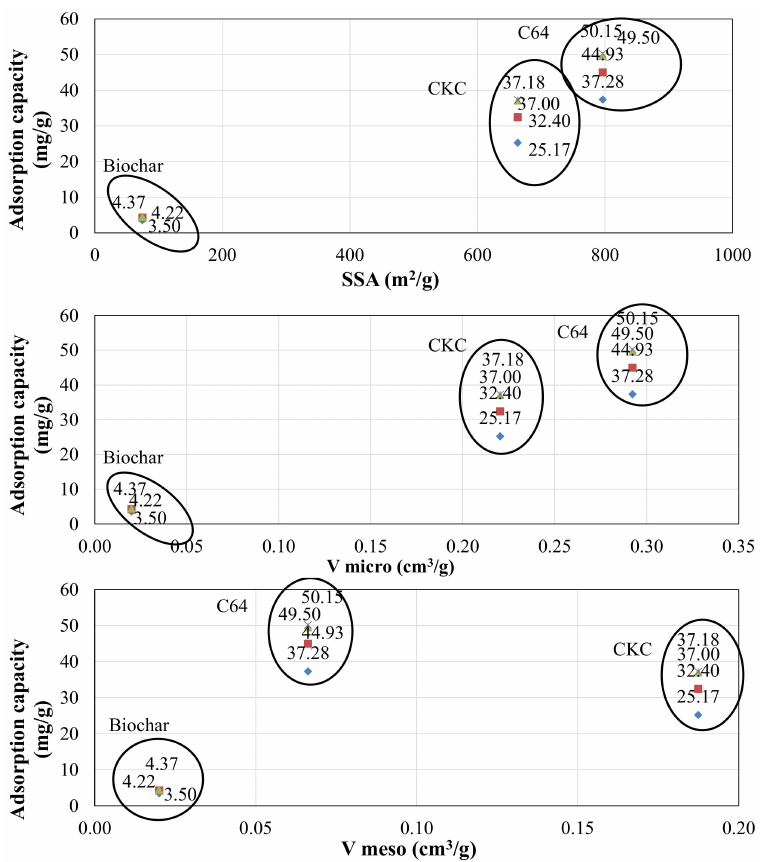
Figure 2. Adsorption capacity values in relation with specific surface area (SSA), and microporous (micro) and mesoporous (meso) volumes. (x 10 ppm(v); ∆ 5 ppm(v); (cid:3) 2 ppm(v);